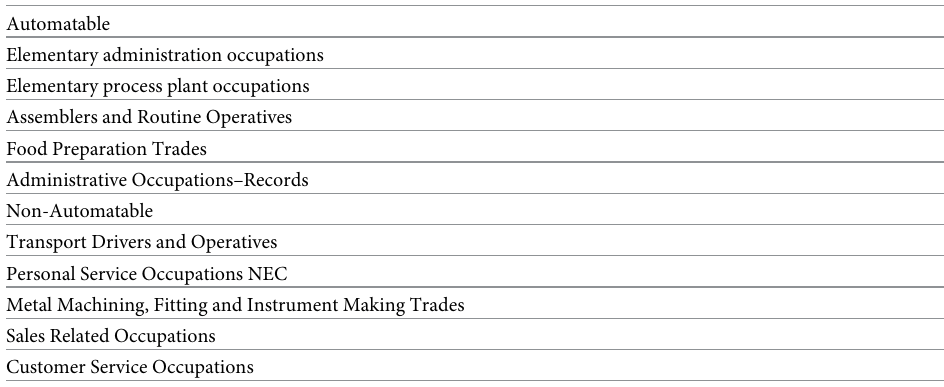
Table 1. Examples of automatable